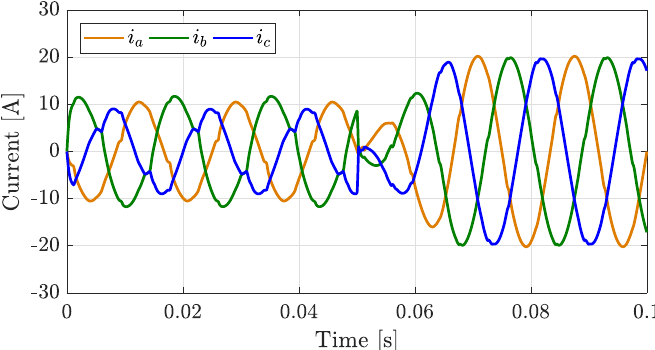
Figure 14. Compensation of PI controller driven by GA under unbalanced linear and nonlinear